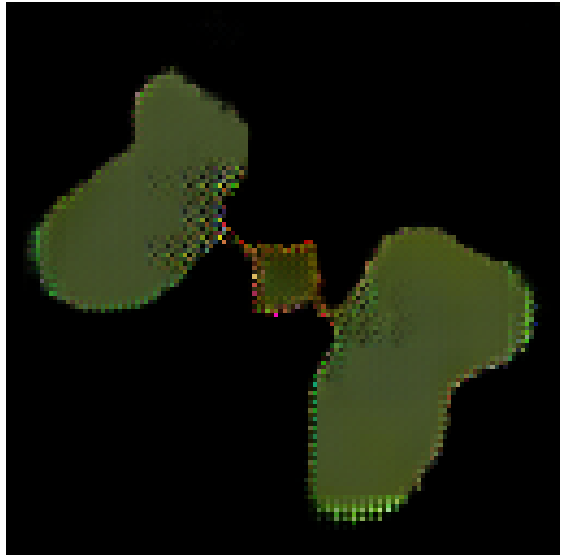
Figure 2. Example of image artefacts in an artificially generated SINAR